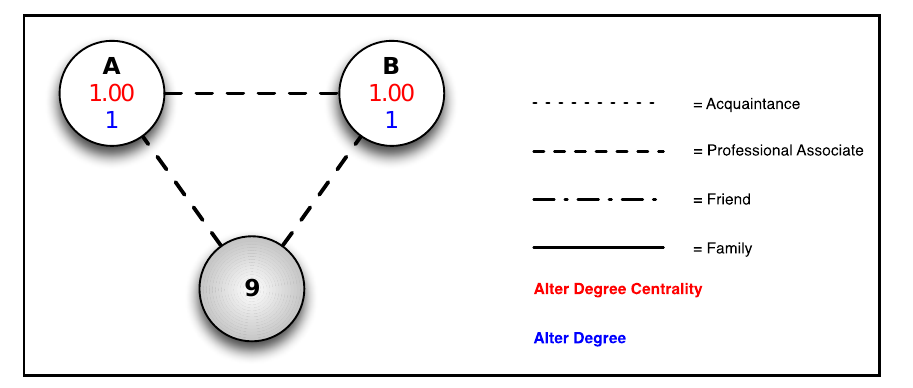
Figure 3. High Density Farmer Advice Network (the Most Common Advice Network Structure)